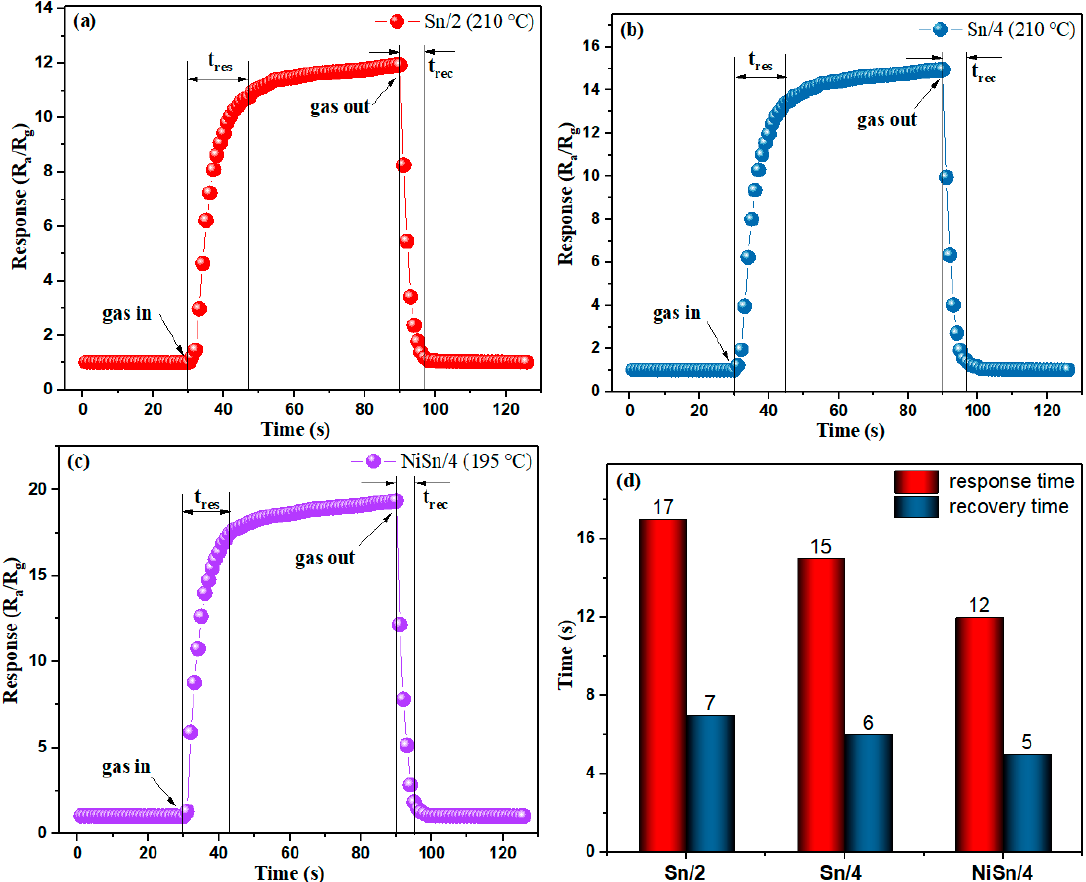
Figure 8. Response and recovery curves to 25 ppm H 2 of ( a ) Sn / 2, ( b ) Sn / 4 and ( c ) NiSn / 4 sensors, and ( d ) the corresponding response and recovery times.